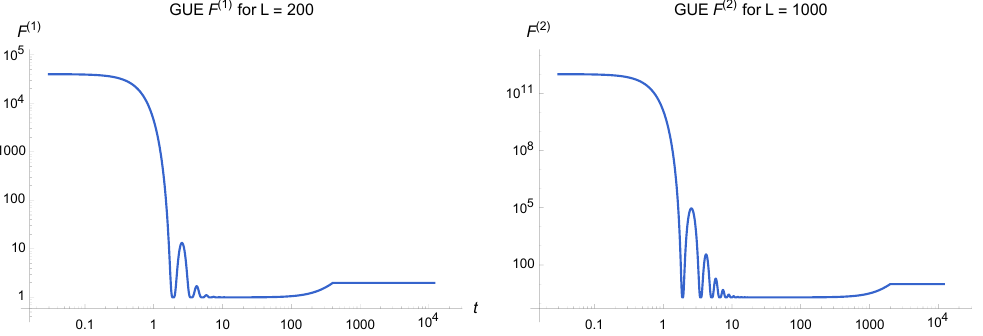
Figure 6 . The (cid:12)rst and second frame potentials for the GUE, using the in(cid:12)nite temperature 2-point and 4-point form factors computed in section 2, plotted for L = 200 and L = 1000, respectively. We observe the decay to the Haar value at the dip time and a subsequent rise at late